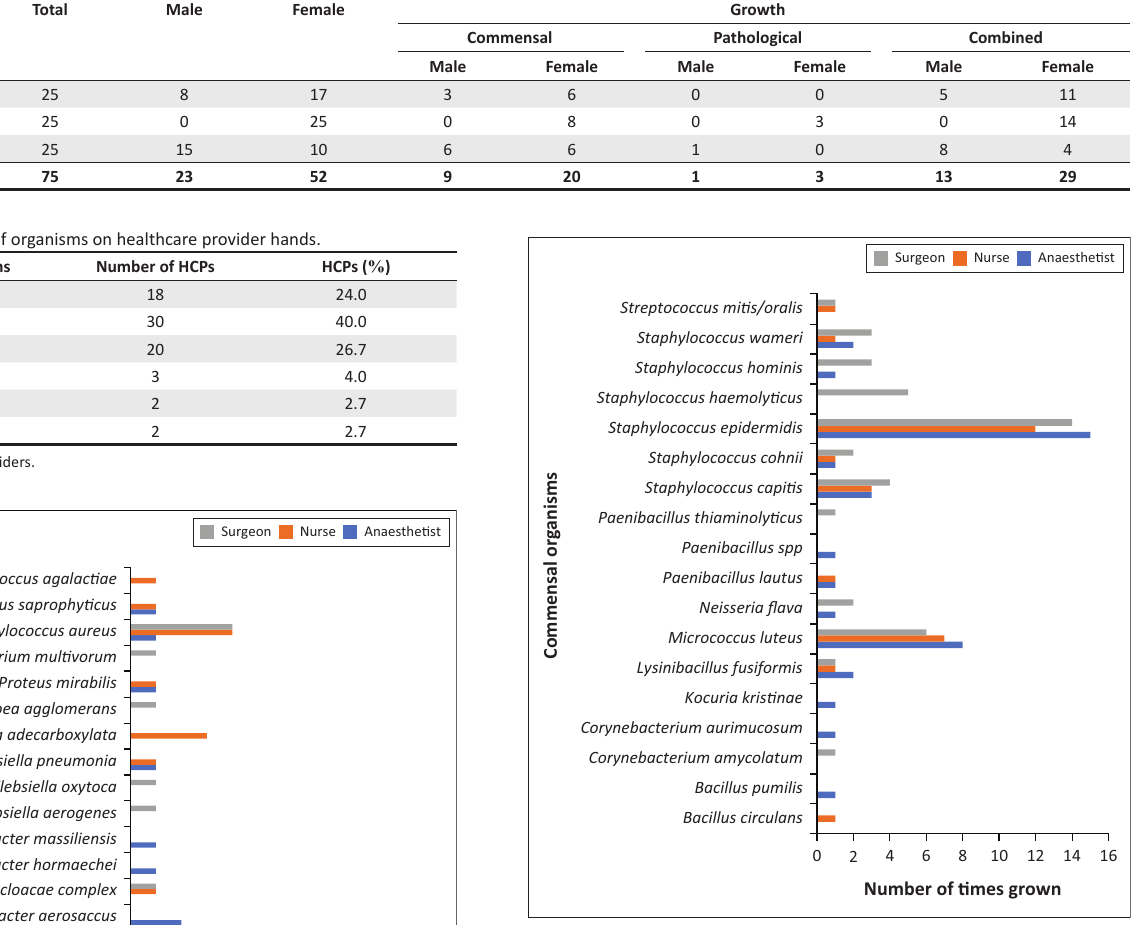
FIGURE 2: Commensal growth among each group.